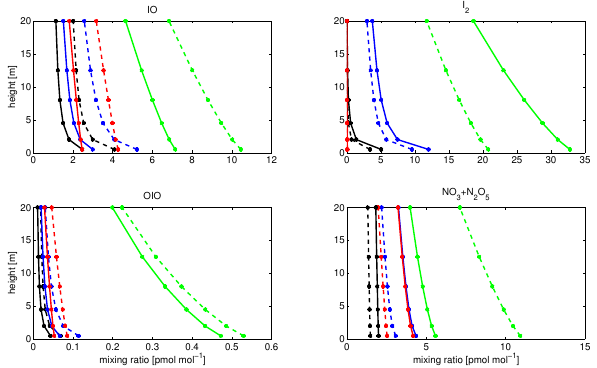
Fig. 13. Mixing ratios of I 2 , IO, OIO, and P NO 3 + N 2 O 5 in the lowest 20m of the model column (data points indicate the centres of model levels). Dashed and solid lines indicate, respectively, the standard and low photolysis testcases. Black and blue lines indicate the base I 2 emission testcases; green and red lines indicate the closer I 2 emission testcases. Red and black lines indicate the standard chemistry testcases; green and blue lines indicate the I 2 recycling